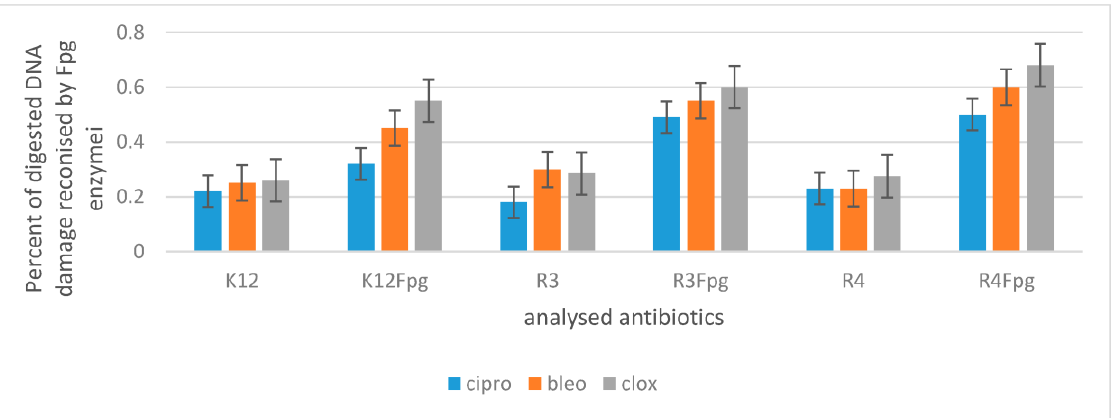
Figure 9. Percentage of bacterial DNA recognized by Fpg enzyme in model bacterial strains after ciprofloxacin, bleomycin, and cloxacillin treatment. The compounds were statistically significant at p < 0.05. — (Supplementary Materials Figure S3).